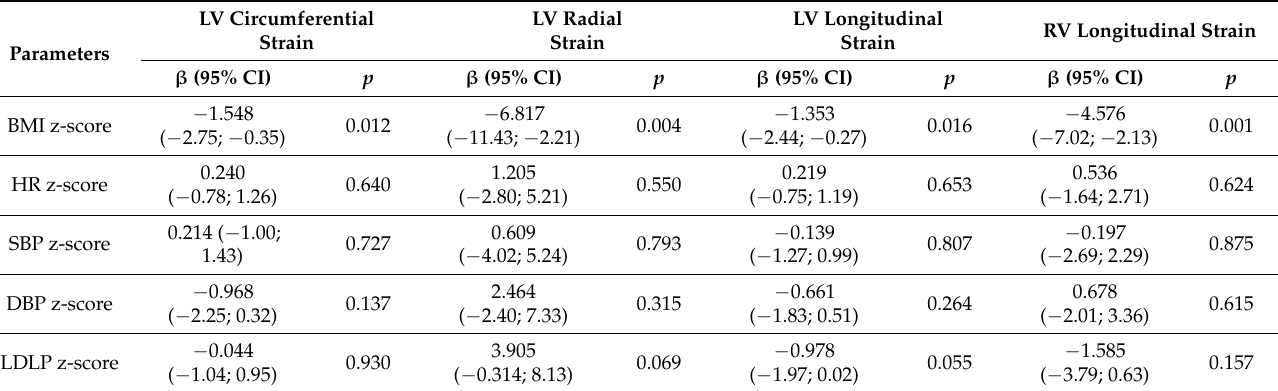
Table 4. Multivariate stepwise linear regression